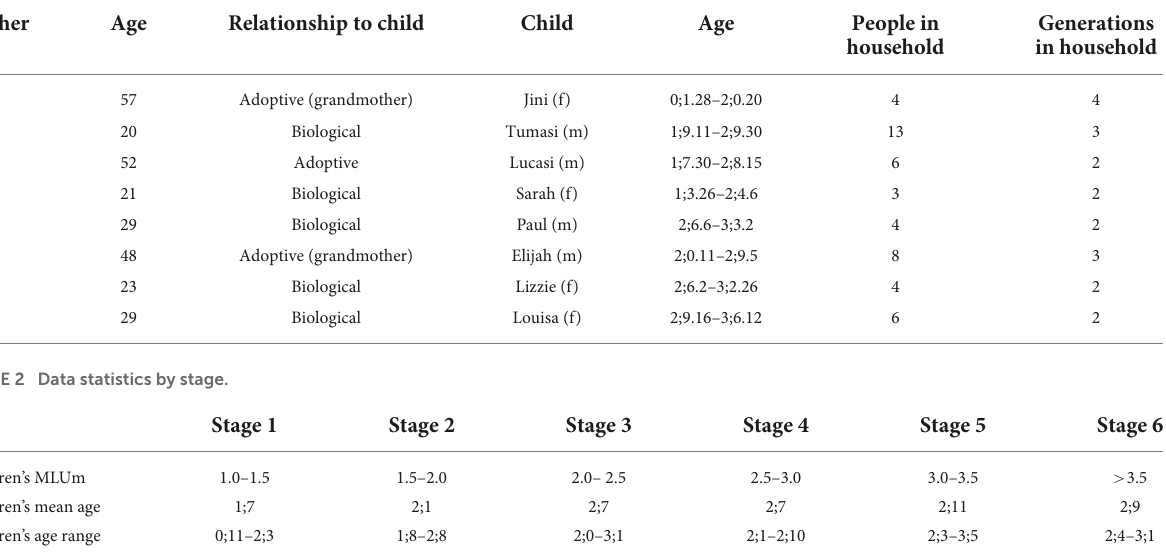
TABLE 1 Participant information (child ages in years; months.days).